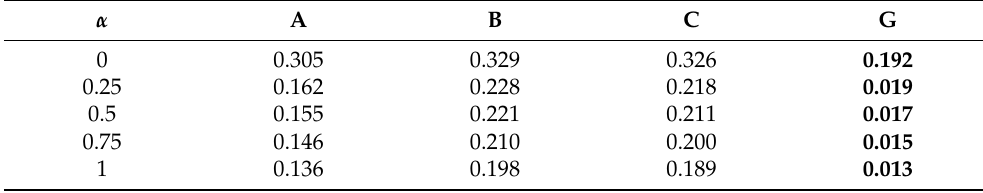
Table 2. Comparison of performance score for severe knee pain with lifting.